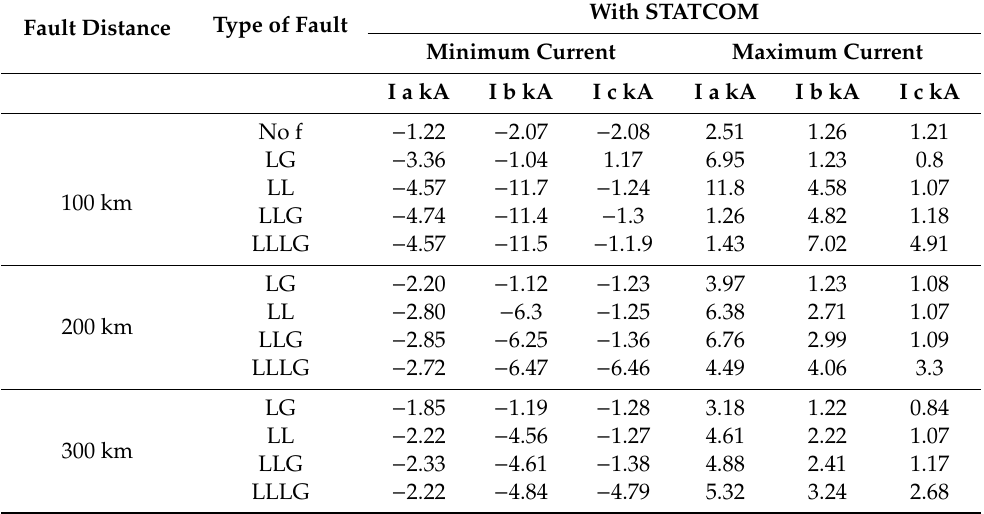
Table 4. Current magnitude during normal conditions and faults at di ff erent locations with